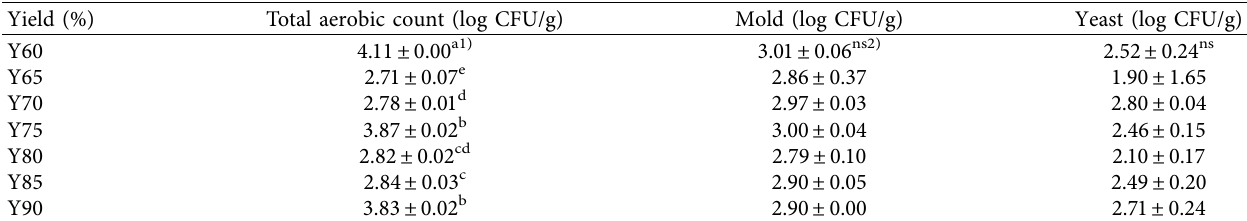
Table 7: Total aerobic, mold, and yeast counts of wheat flour (var. Jokyoung) according to flour yield. Yield (%)